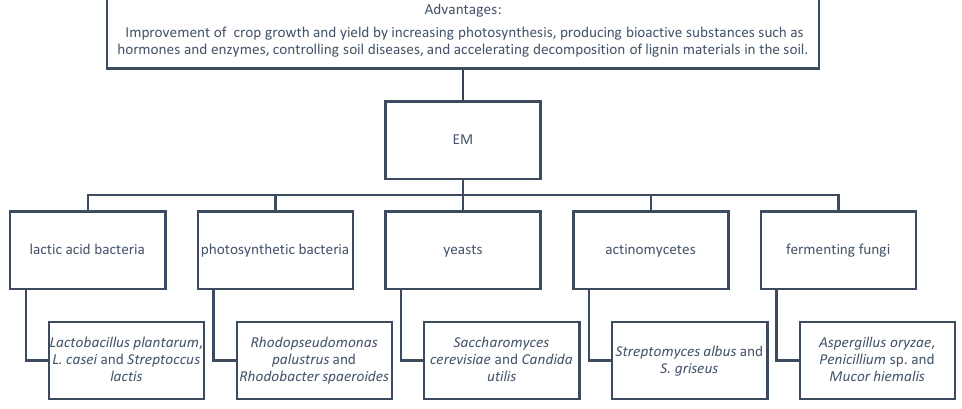
Figure 1. Effective microorganisms (EM) with their compositions [147–149].